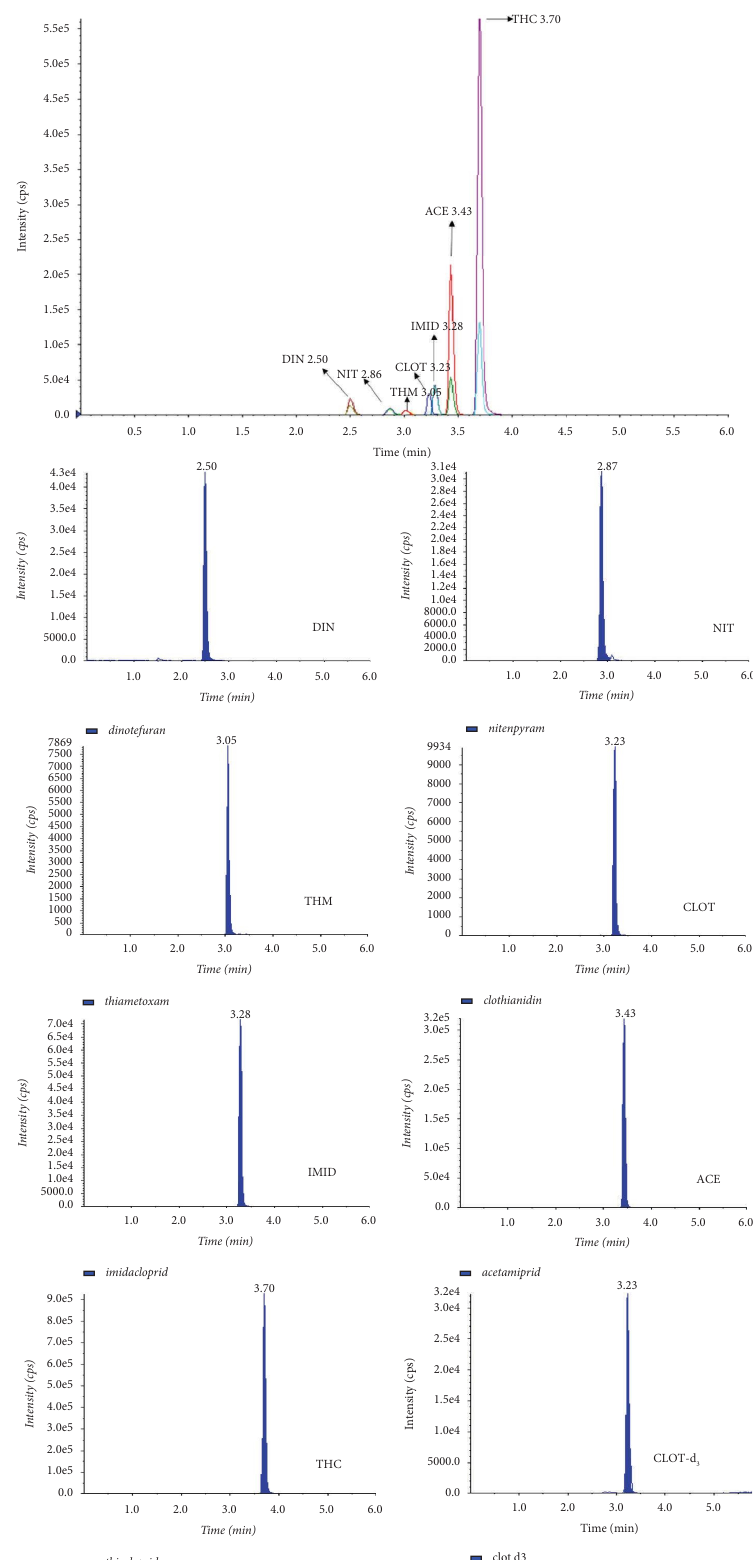
Figure 1: Chromatograms of total ion chromatogram and fortifed spiked honey samples (according to MRL or LOQ). DIN, dinotefuran; NIT, nitenpyram; THM, thiamethoxam; CLOT, clothianidin; IMID, imidacloprid; ACE, acetamiprid; THC, thiacloprid; CLOT-d 3 , clothianidin-d 3